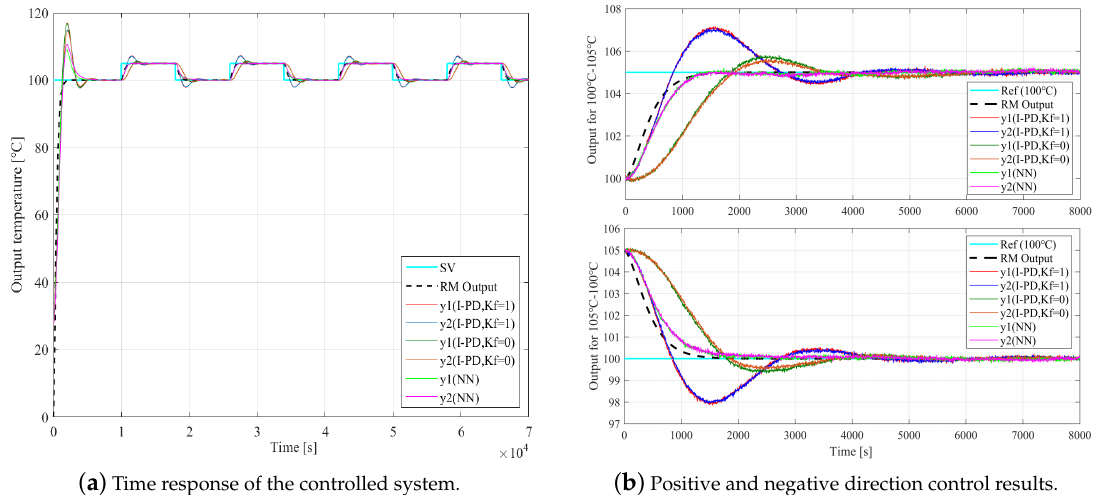
Figure 11. Experimental results. ( a ) Time response for the controlled system. ( b ) Results of positive direction control for the temperature from 100 ◦ C to 105 ◦ C and negative direction control for the temperature from 105 ◦ C to 100 ◦